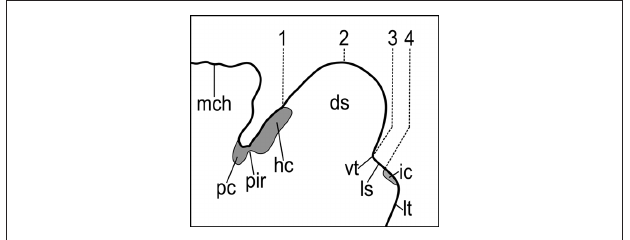
Figure 5 | Midsagittal section of the prosencephalic roof plate in P. marinus illustrating the dorsal telencephalic/diencephalic limit in either the columnar or the segmental conceptions of the neural tube . 1, Edinger (1888), von Kupffer (1906), Heier (1948), Schöber (1964), Nieuwenhuys and Nicholson (1998); 2, Burckhardt (1894); 3, Sterzi (1907), Pombal and Puelles (1999); 4, Ahlborn (1883), Pombal et al. (2009), Martínez-de-la-Torre et al. (2011). ds, dorsal sac; hc, habenular commissure; ic, interbulbar commissure; ls, lamina supraneuroporica; It, lamina terminalis; mch, mesencephalic choroidal plexus; pc, posterior commissure; pir, pineal recess; vt,